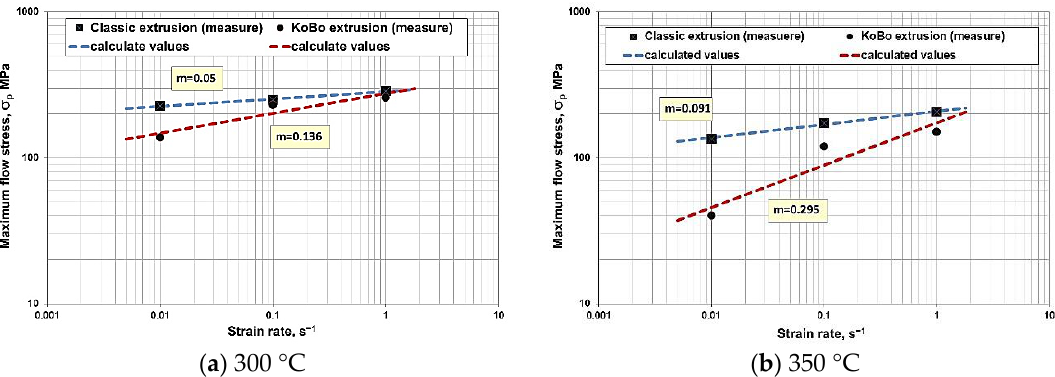
Figure 8. The strain rate sensitivity coefficient (m) depending on strain rate in the logarithmic system ( a ) 300 °C, ( b ) 350 °C.